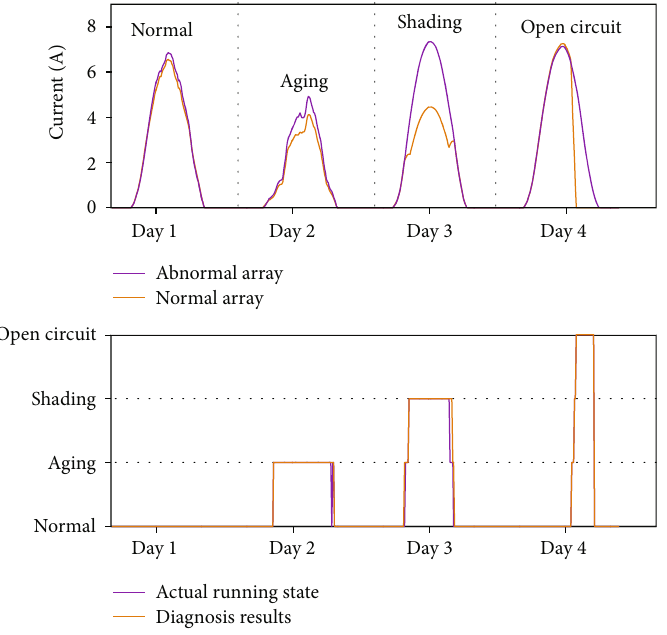
Figure 8: Fault diagnosis